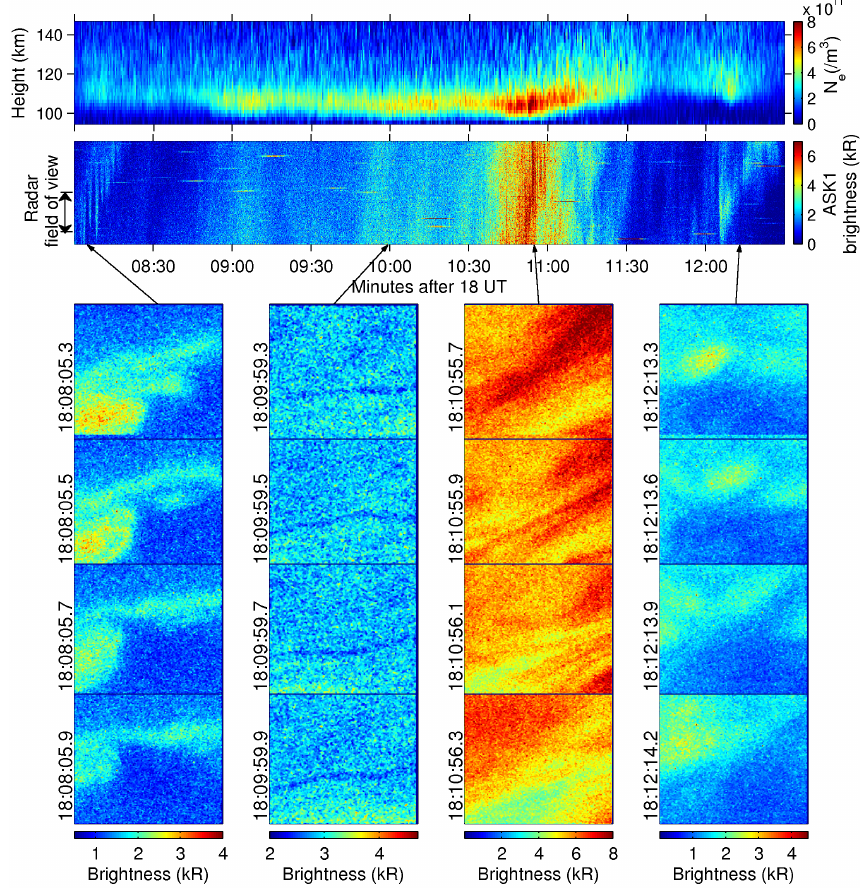
Fig. 4. Overview of the variations between 18:08:00UT and 18:12:30UT. (top panel) electron density (second panel) emissions in ASK1 and (lower panels) selected images during 1s intervals as marked with